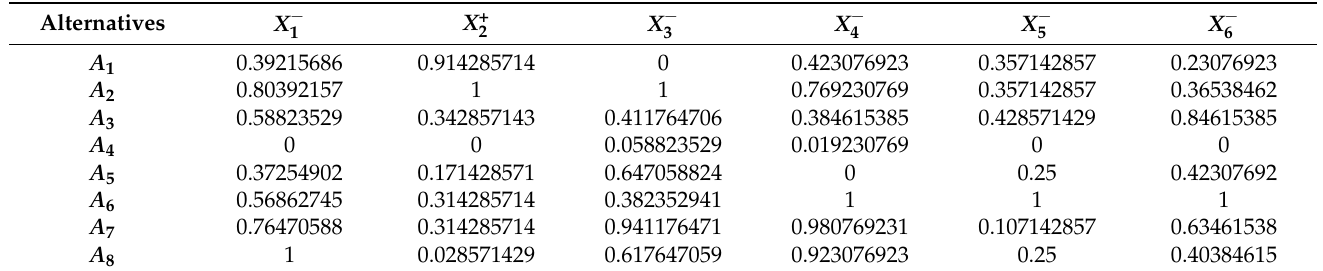
Table 8. Normalized decision matrix.